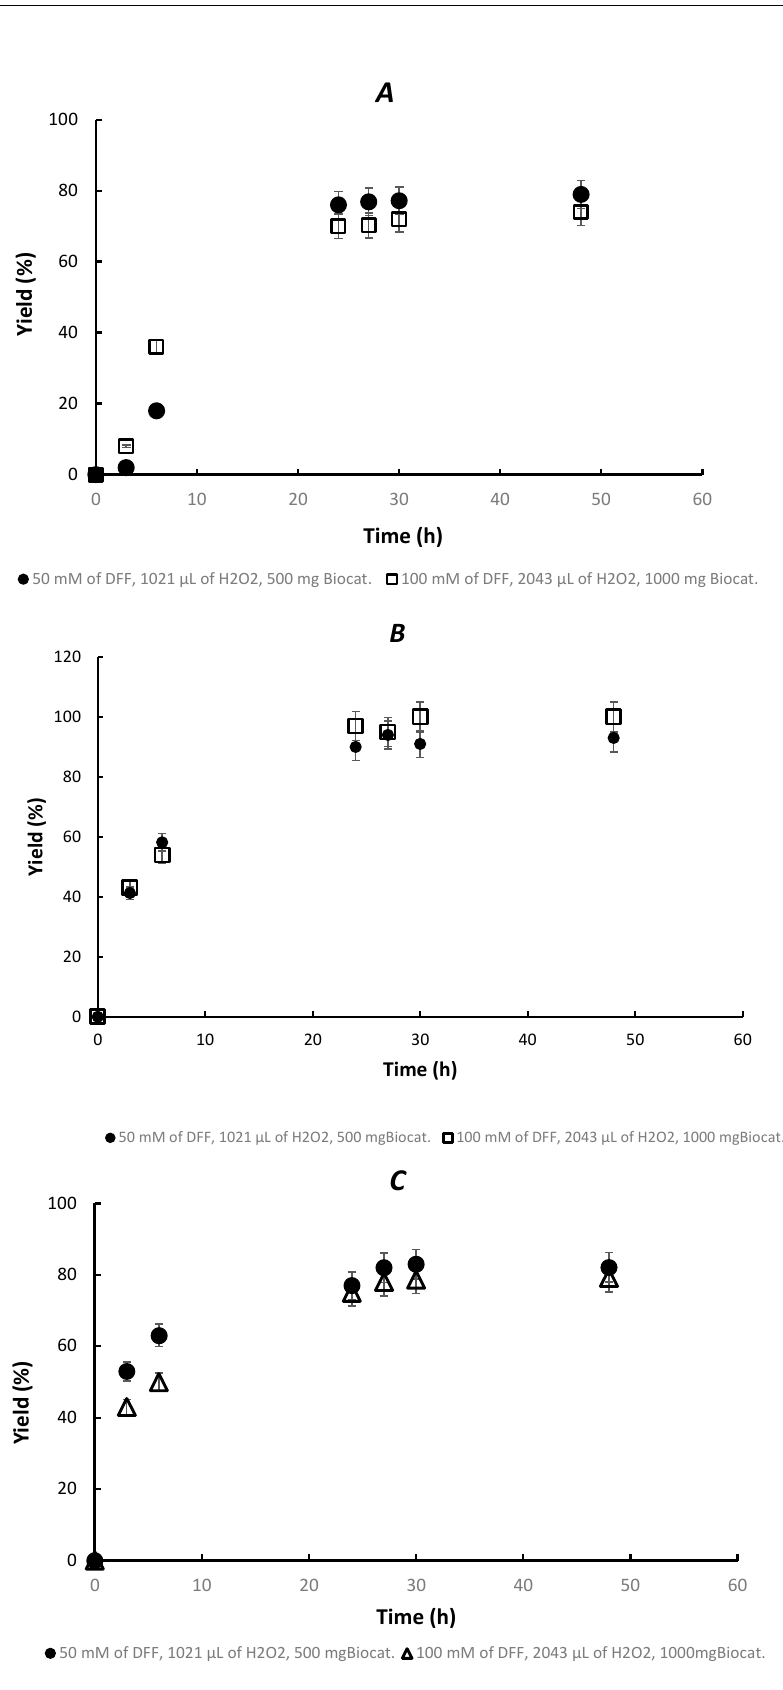
Figure 4. Chemoenzymatic synthesis of FDCA in a fed-batch bioreactor. Operational conditions: 10 mL of reaction volume and 40 ◦ C. One inlet at a flow rate of H 2 O 2 : ( A ) 1 µ L/min; ( B ) 3 µ L/min; and ( C ) 5 µL/ min.